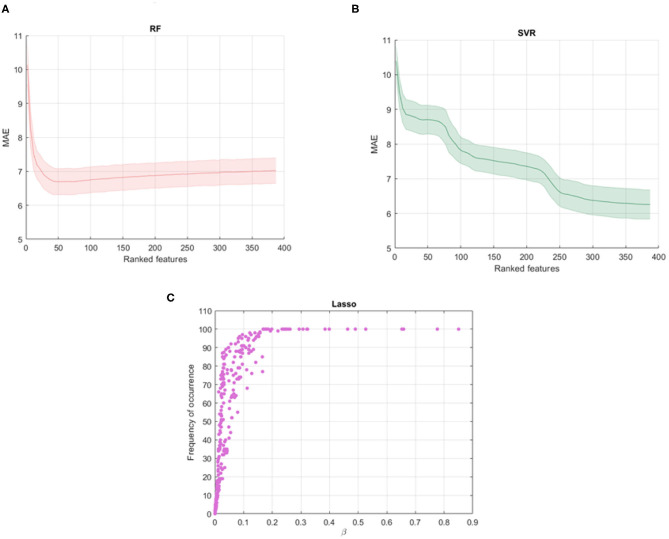
Shadow performance curves with the average MAE achieved by all the stepwise models in cross-validation with the standard errors for (A) RF models and (B) SVR models; (C) averaged weights vs. frequency of occurrence of the features across all the validation rounds resulting from Lasso algorithm.